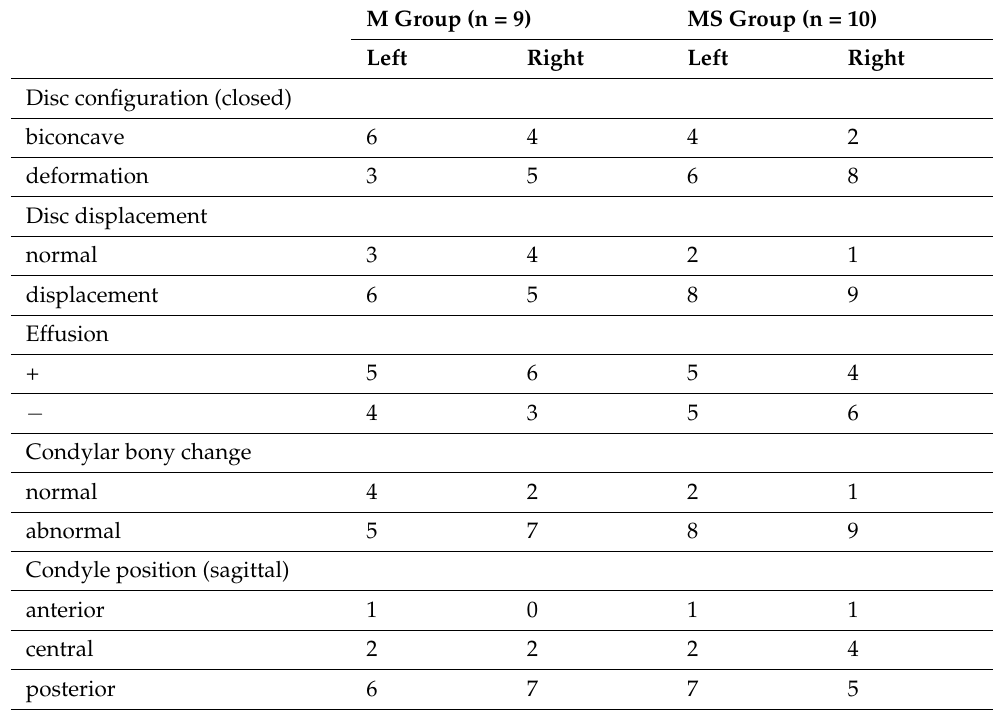
Table 7. A comparison of the TMJ between the M group and the MS